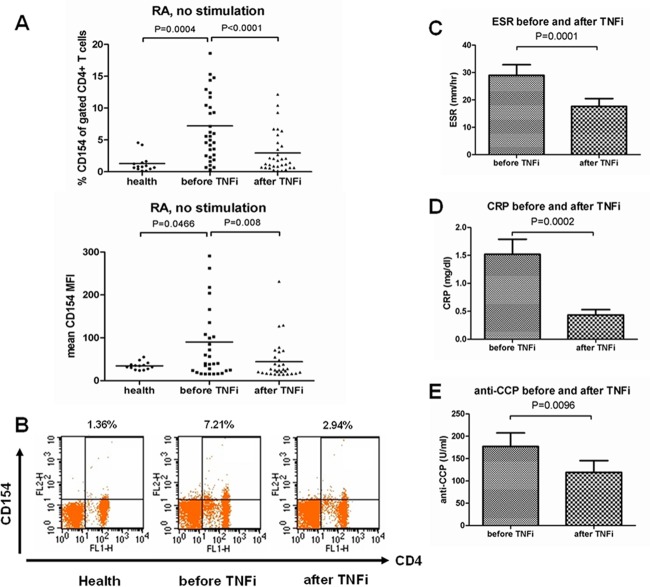
CD154 expression levels and clinical parameters in RA patients before and after TNF-α blockade treatment.(A) and (B) PBMCs were isolated from health control (n = 14) and RA patients (n = 33) before and after TNF-α blockade treatment for 3 months. The CD154 expression levels (CD154 percentage and MFI of gated CD4+ T cells) were measured by flow cytometry. Data were presented as means. Comparison of clinical parameters including ESR (C), CRP (D) and anti-CCP autoantibody (E) in RA patients before and after TNF-α blockade treatment. Data were presented as means ± SEM. TNFi: TNF-α inhibitor; MFI: mean fluorescence intensity; ESR: erythrocyte sedimentation rate; CRP: C-reactive protein; anti-CCP: anti-cyclic citrullinated peptide antibody.